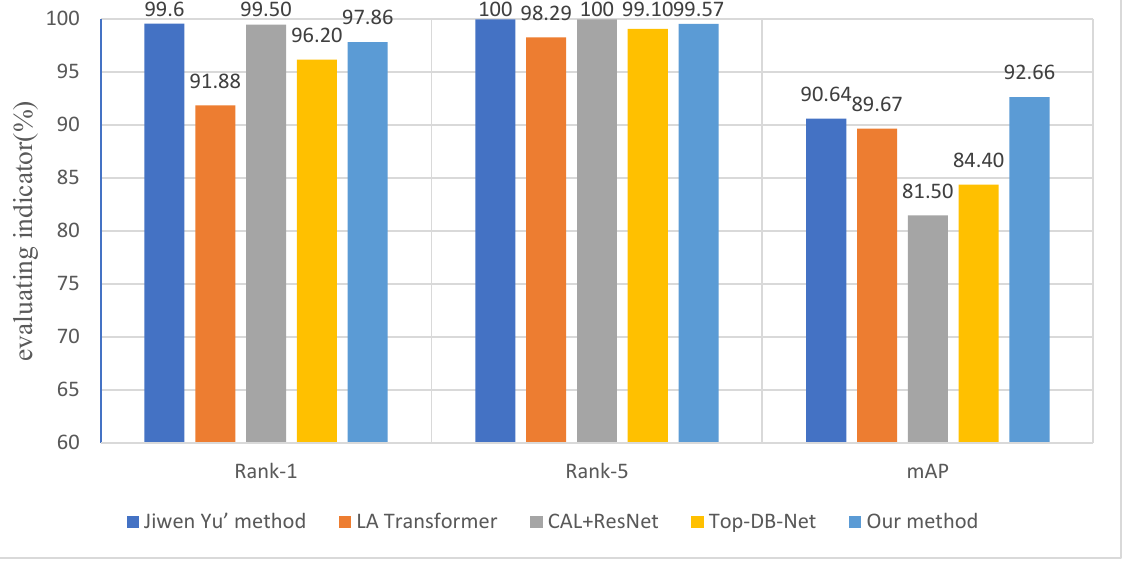
Figure 8. mAP values of the different layer structures. 3.4. Comparison against the State of the Art The datasets mainly included four categories of images: body appearance, color face, gray face, and complex face datasets. Since existing studies have conducted experiments on these datasets, in order to fairly evaluate our model from multiple perspectives, we chose the state-of-the-art models corresponding to each type of dataset for the compari- son: the Yu et al. model for the ATRW dataset; the Tri-AI model for color face and gray